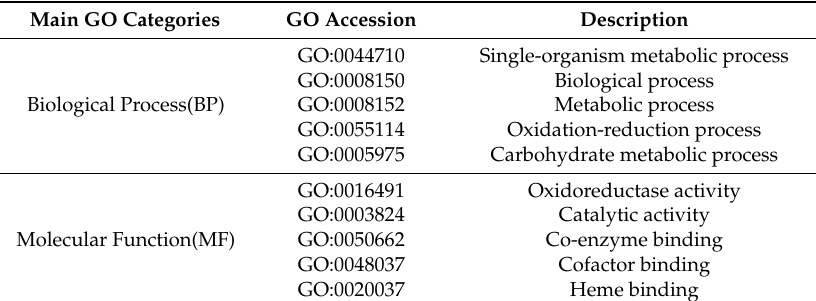
Table 2. The DEGs involved in three KEGG pathways with the highest rich factor *.